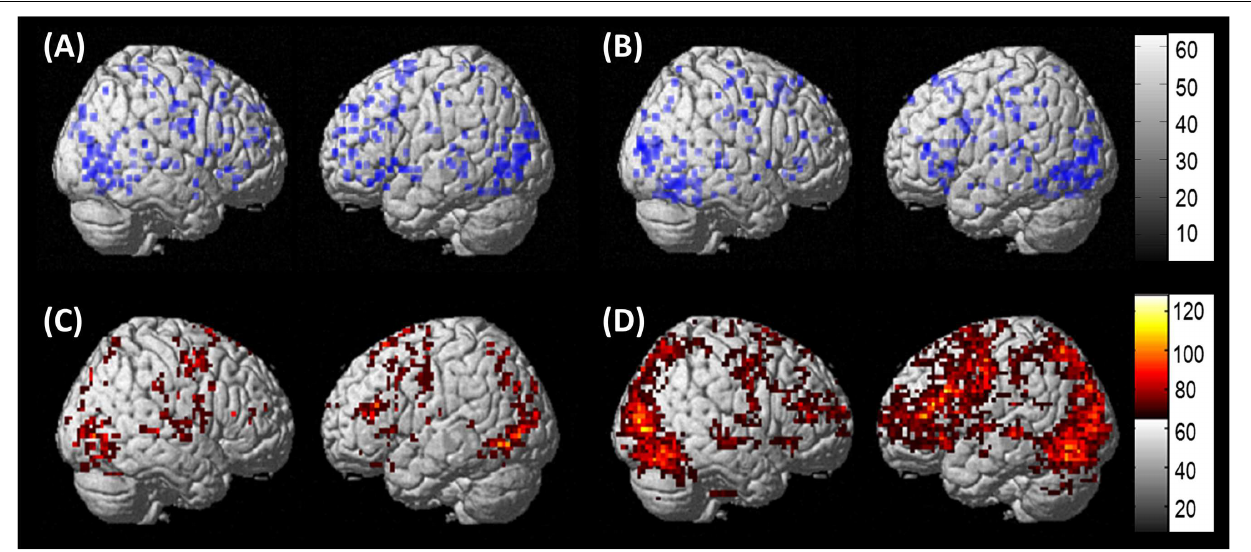
FIGURE 5 | Whole brain activation. (A) Results of the one-sample t -test in PWA at uncorrected ( t = 3.05, p < 0.005) for pictures > scrambled pictures . (B) Results of the one-sample t -test in controls at uncorrected ( t = 3.25, p < 0.005) for pictures > scrambled pictures . (C) Overlap of the 13 individual PWA activation maps at uncorrected ( p < 0.001), cluster size of 3 voxels for pictures – scrambled pictures . (D) Overlap of the 10 individual control activation maps at uncorrected ( p < 0.001), cluster size of 5 voxels pictures – scrambled